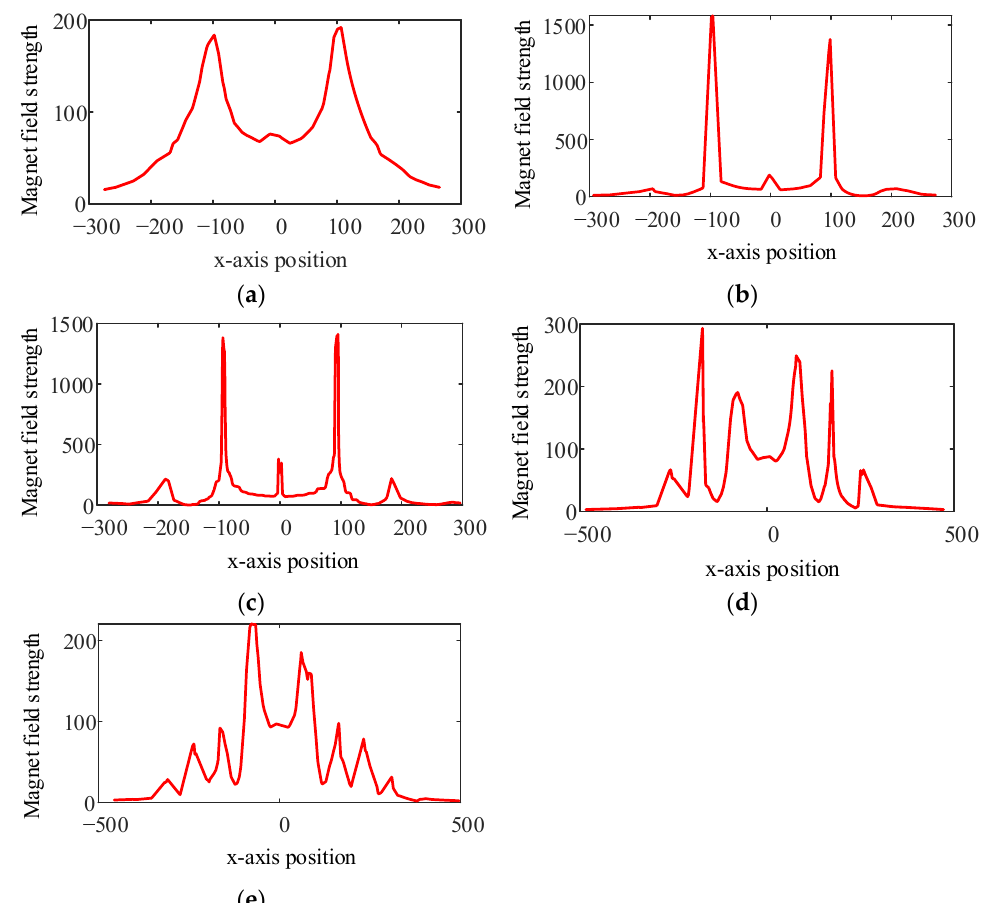
Figure 21. Curves of the magnet field strength on the x ‐ axis. ( a ) N = 2, ( b ) N = 4, ( c ) N = 6, ( d ) N = 8, ( e ) N = 10.